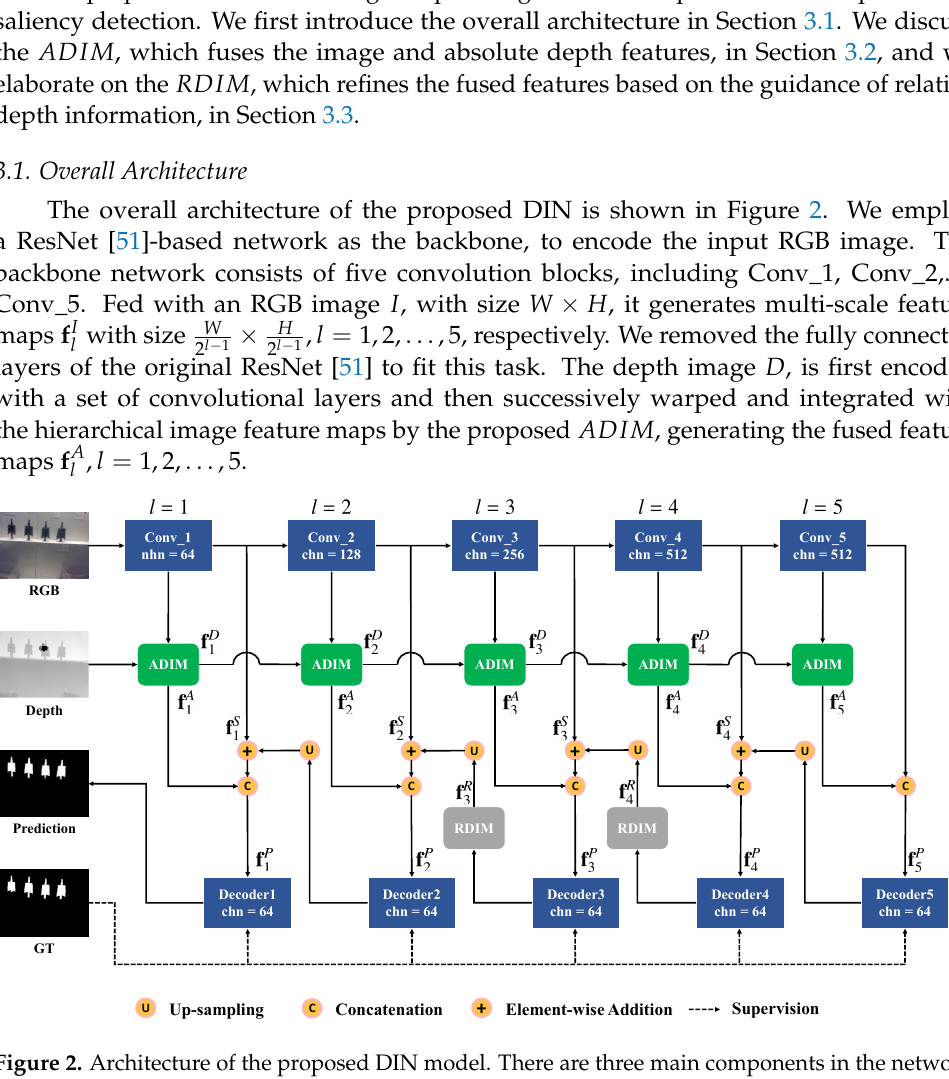
Figure 2. Architecture of the proposed DIN model. There are three main components in the network: the backbone network; the ADIM , which fuses RGB and depth images in the encoding stage; and the RDIM , which complements relative depth cues in the decoding